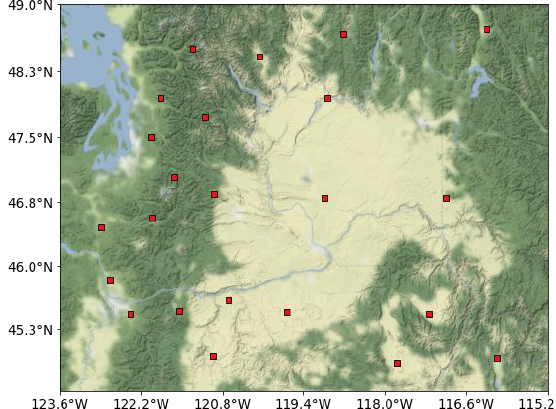
Figure 3. Map of the study area and the satellite positioning reference stations